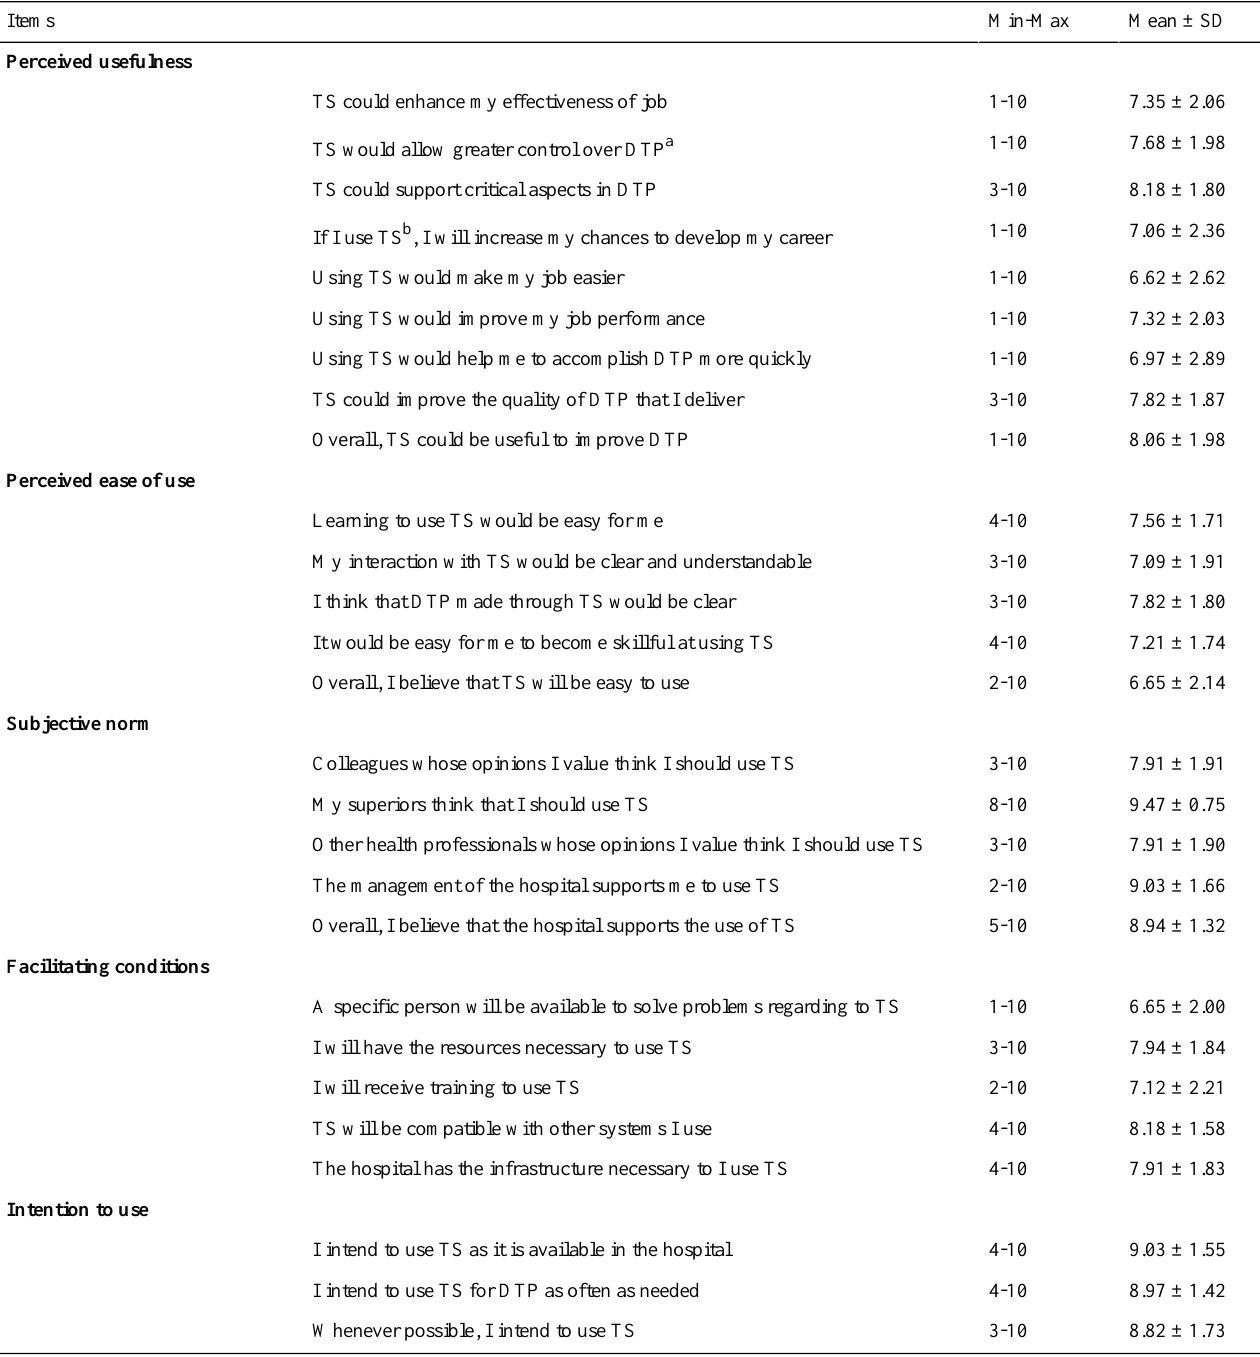
Table 5. Descriptive statistics of the TAM questionnaire